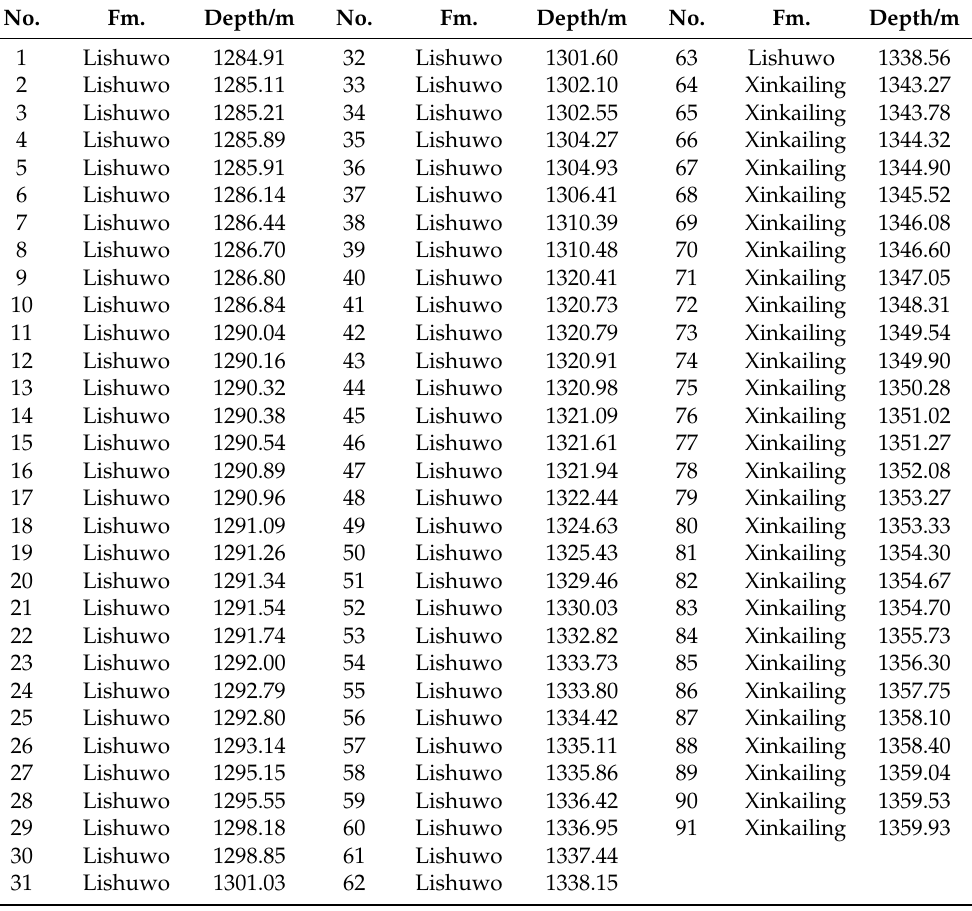
Table 2. The sample numbers, formations and burial depths of the samples from Well X for X-ray fluorescence spectrometer. See Figure 1 for the well location.